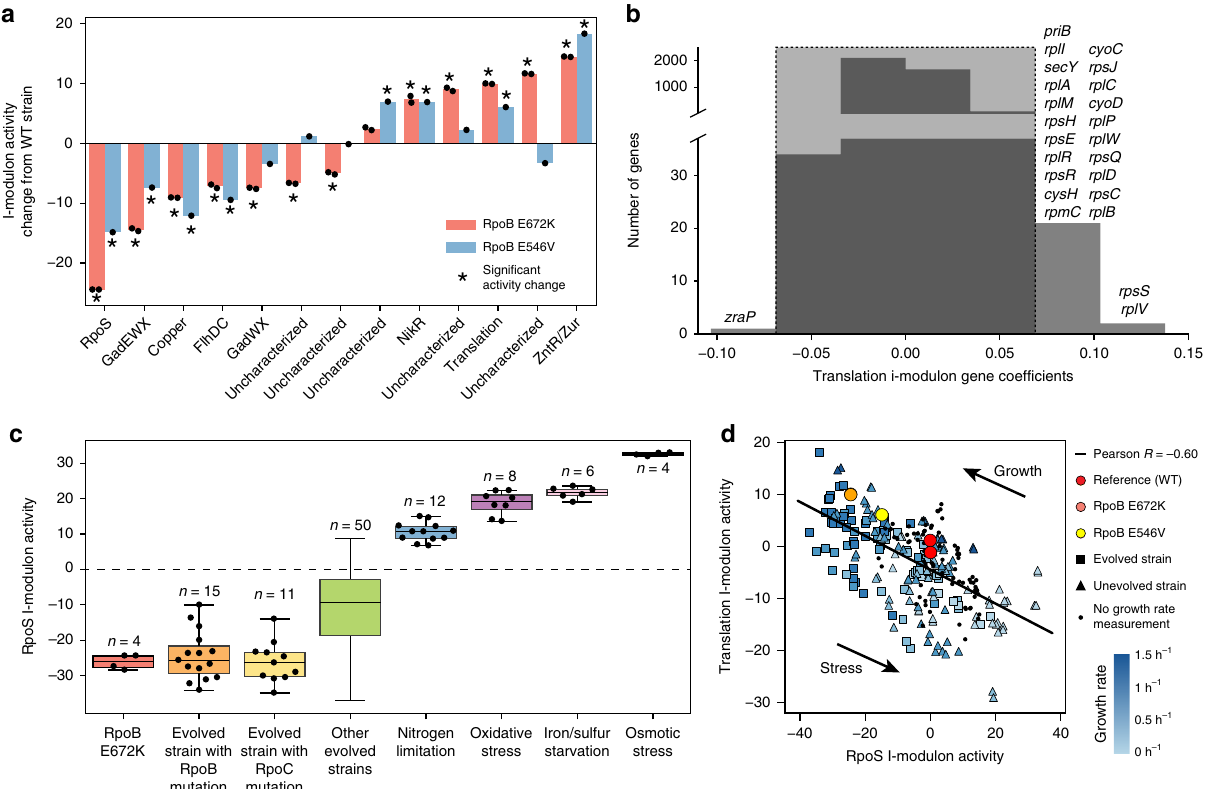
Fig. 5 Two i-modulons characterize the ‘ Fear vs. Greed ’ Tradeoff. a Comparison of i-modulon activities in the RpoB E672K and RpoB E546V mutant strains grown on glucose minimal media against wild-type activities. Signi fi cant i-modulon activities are designated by asterisks (see the “ Methods ” section). For detailed information about these i-modulons, see Supplementary Data 2. b Histogram of translation i-modulon gene coef fi cients. Gene names are shown for genes above threshold. c The RpoS i-modulon activities revealed the stress level of the cell under various conditions. Boxplot whiskers represent extrema, box bounds represent upper and lower quartiles, and center-line represents the median value. d The RpoS i-modulon activities were anti- correlated with the Translation i-modulon activities, highlighting the trade-off between stress-hedging and growth. Single nucleotide mutations in RpoB (in yellow and orange) shifted cellular resources along this line from the wild-type strain (in red). Points were colored by growth rate measurements when